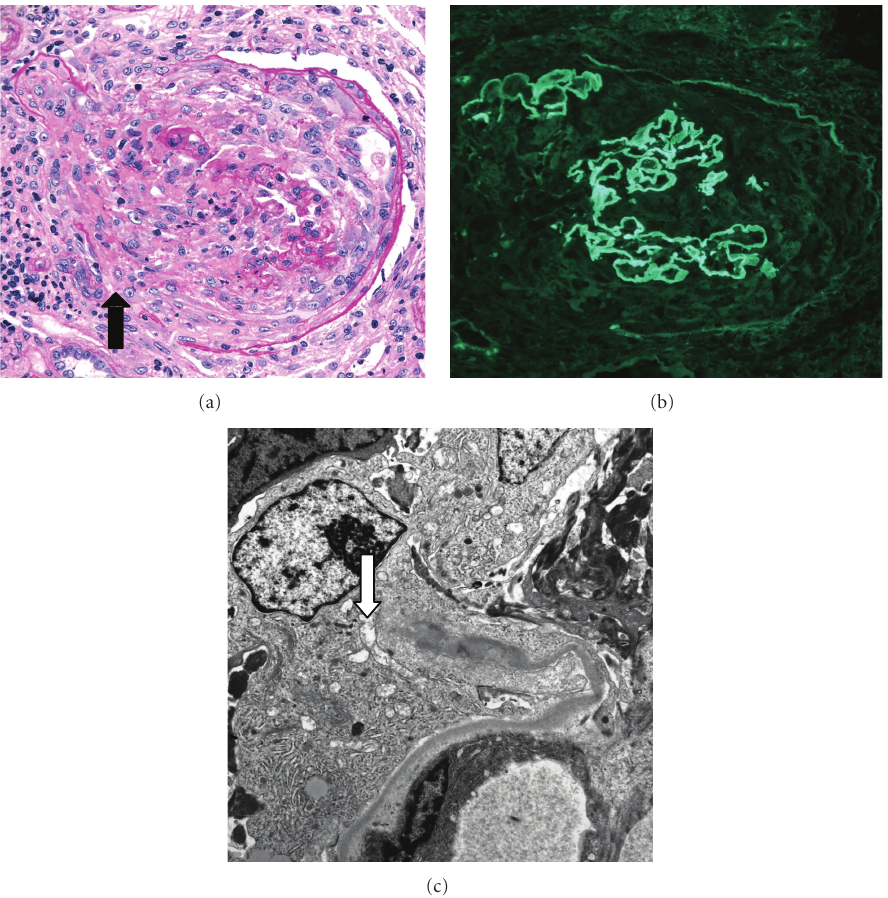
Figure 1: Glomeruli from the renal biopsy. (a) Cellular destructive crescent with discontinuities in Bowman’s capsule (arrow). The adjacent interstitium had edema and a mononuclear leukocytic infiltrate. Periodic acid-Schi ff × 250. (b) Immunofluorescence showing strong (3-4+) linear IgG staining along capillary walls. The capillary walls are disrupted focally due to crescent formation × 250. (c) Broken glomerular capillary wall (arrow) associated with a cellular crescent. There are no capillary wall electron dense deposits ×